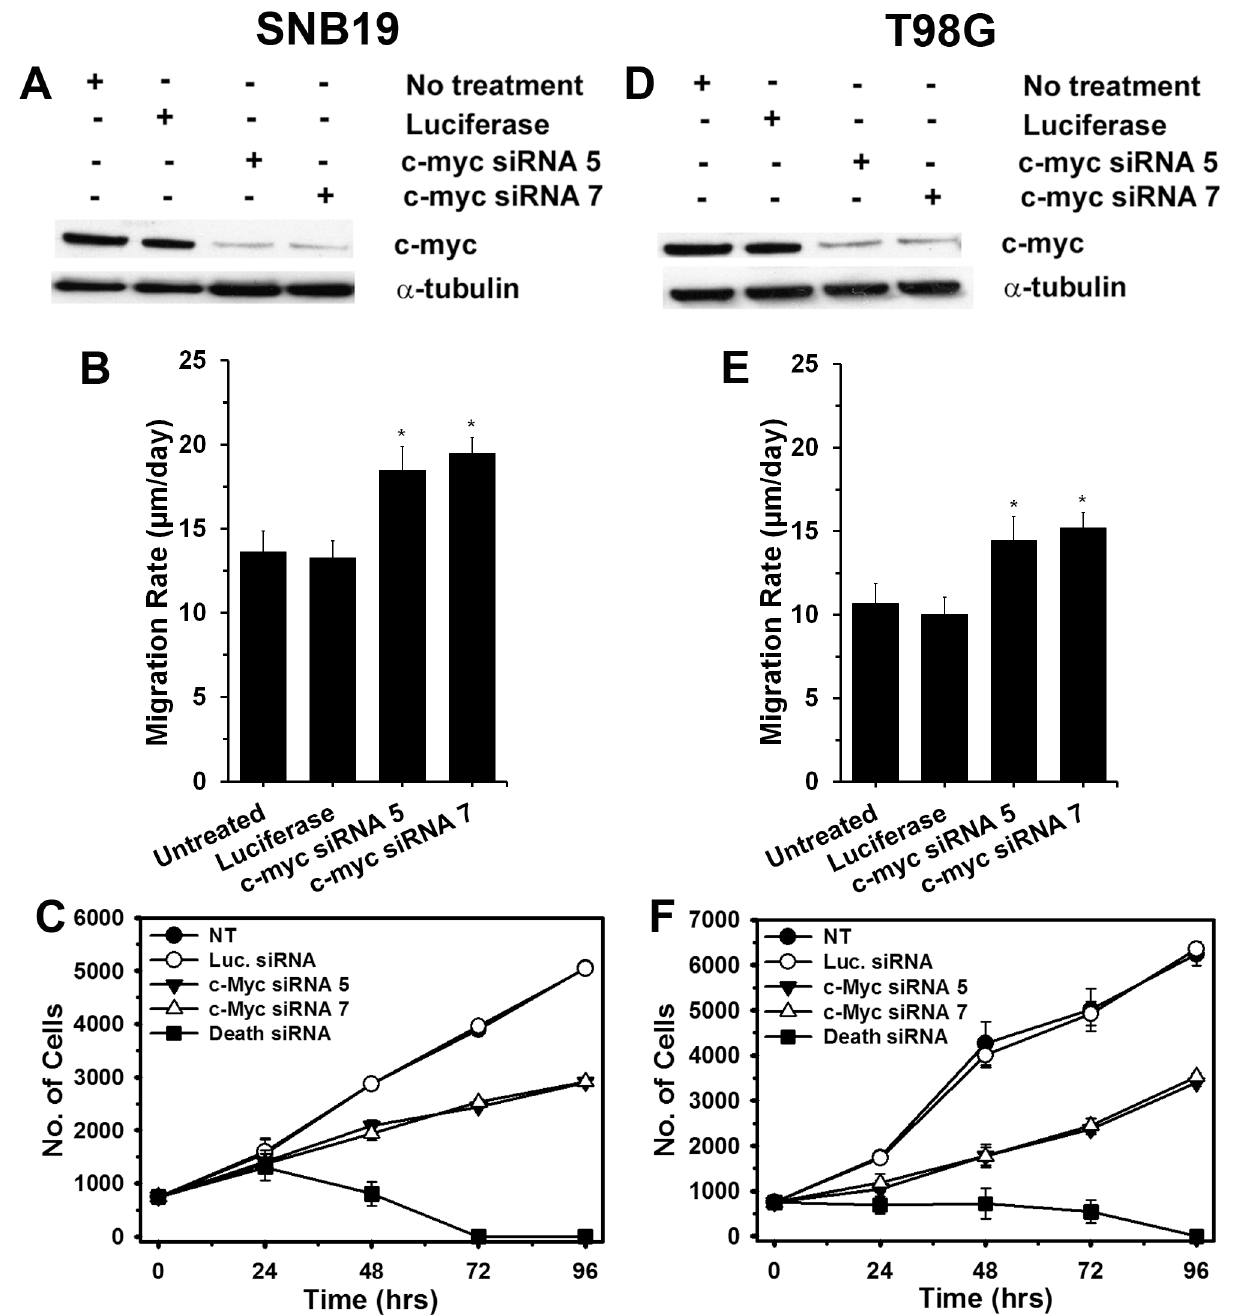
Figure 7. Knockdown of c-Myc using siRNA increases glioma cell migration and reduces glioma cell proliferation. Western blot analysis ( a -tubulin used as a loading control) to confirm reduction of c-Myc in the glioma cell lines (A) SNB19 and (D) T98G transfected with two c- Myc–specific siRNA. Untransfected cells and cells transfected with a control siRNA (luciferase) are shown for comparison. Treatment with two separate c-Myc siRNA increased migration of (B) SNB19 and (E) T98G cells in a radial migration assay when compared with untreated or luciferase-transfected cells (p , 0.001, 2-tailed Student’s t-test). Treatment with two c-Myc siRNA suppressed proliferation of (C) SNB19 and (E) T98G as demonstrated by alamar blue assay when compared with untreated or luciferase transfected cells. Cell Death siRNA (Qiagen) was utilized in the proliferation assay as internal experimental control. doi:10.1371/journal.pone.0072134.g007 Myc also consistently represses genes involved in cell growth arrest a decrease in cell proliferation (Figure 7). This observation affirms and cell adhesion [46,48]. In support of these previous findings we that cell proliferation and migration are two associated but show that when c-Myc is depleted, glioma cells switch their dichotomous processes and cells have lesser tendency to migrate when they are proliferating. On the other hand, there is proliferative phenotype to a migratory phenotype accompanied by